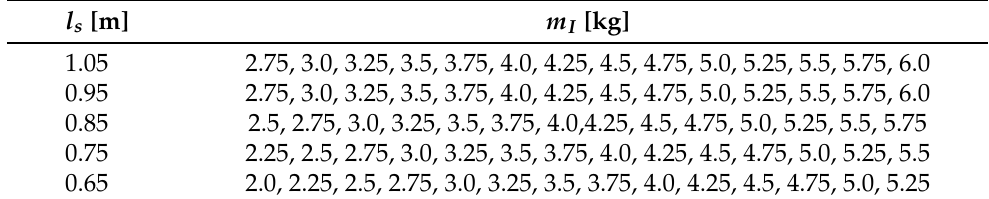
Figure 3. The ( a ) sketch and ( b ) photo of the experimental facilities. Table 1. The initial settings of all the